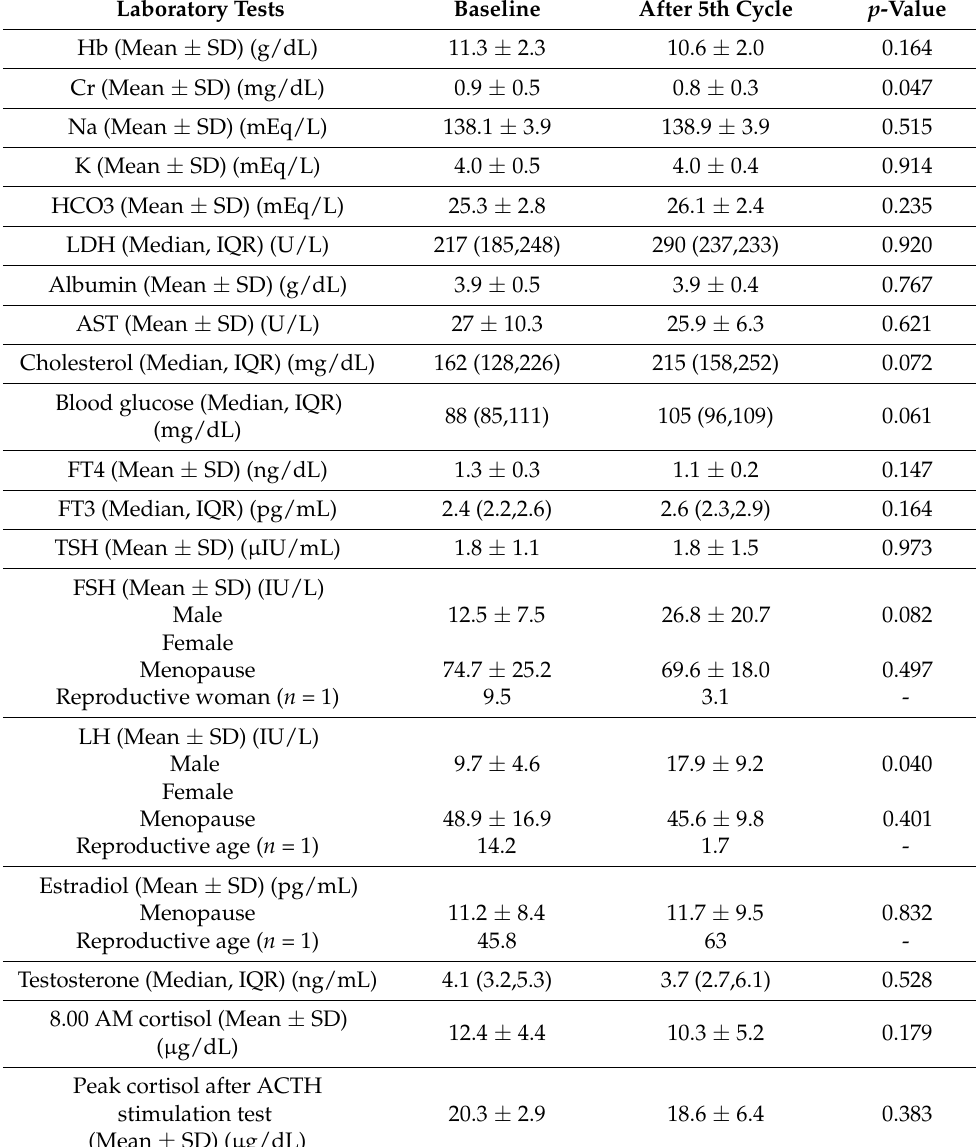
Table 2. Hormonal features and metabolic profiles before 1st cycle and after 5th cycle of R-CHOP. Laboratory Tests